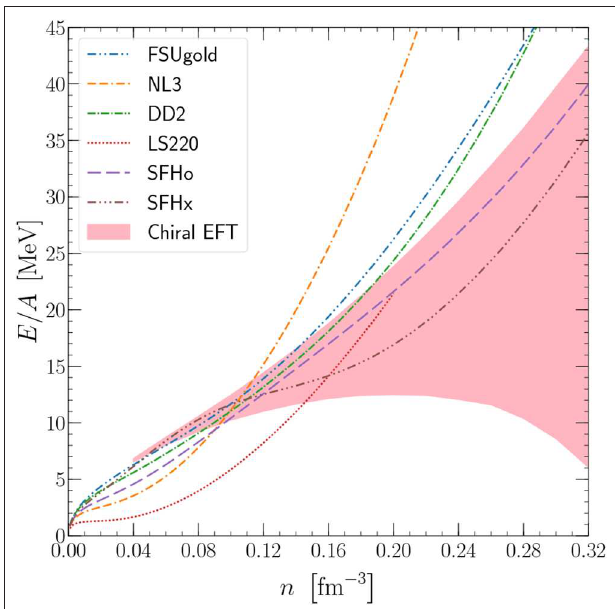
FIGURE 4 | EOS of PNM obtained from QMC calculations with local chiral interactions at N 2 LO from Tews et al. [33]. The band indicates the theoretical uncertainty of the calculation, which mainly originates in the uncertainty of the nuclear interaction [3]. The chiral EFT band is compared with several model EOS for astrophysical calculations. Republished with permission of IOP Publishing, from Gandolfi et al. [ 30]; permission conveyed through Copyright Clearance Center,